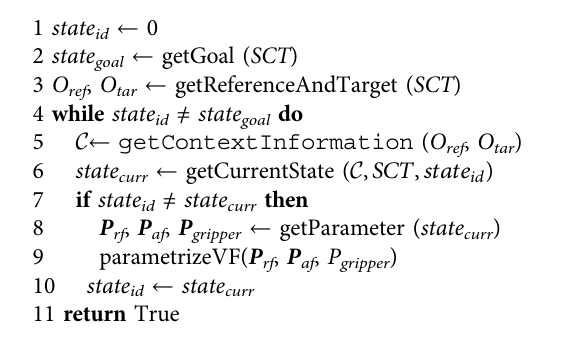
Algorithm 1. Pseudocode of the SCOPE main loop to parse SCTs and parameterize VFs.